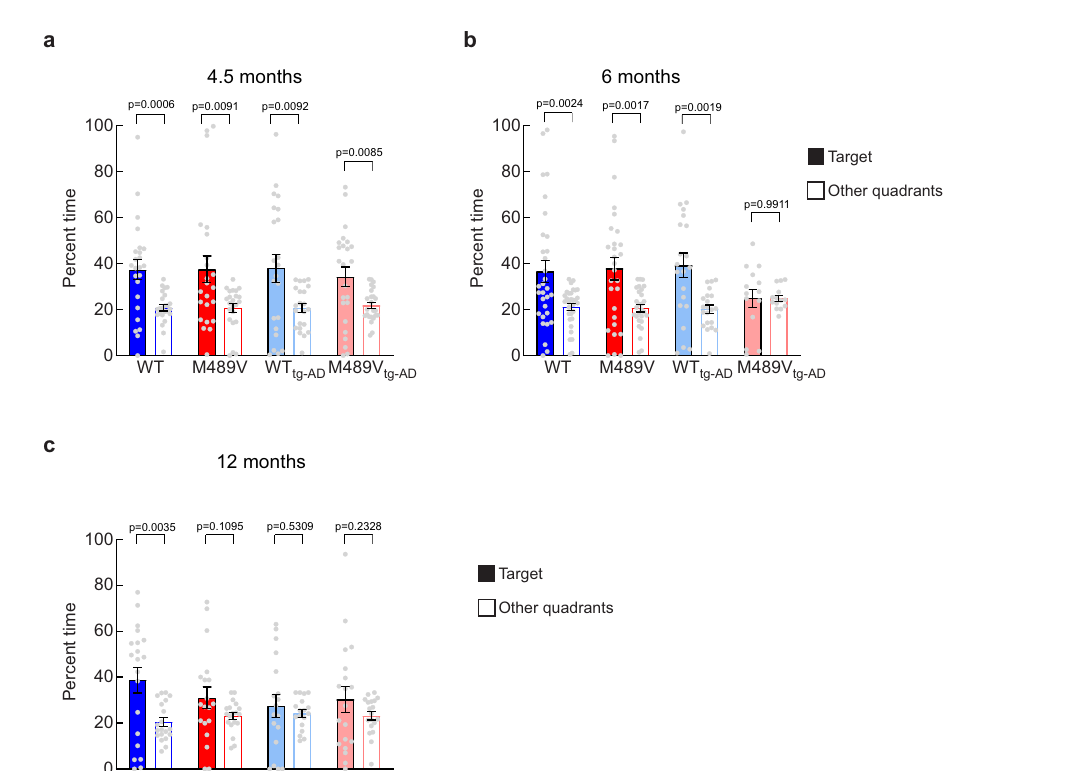
showing the distribution of phosphopeptides from C9 Graph depicts the median± interquartile range (values of p <0.05 using a two-tailed Student ’ s t test, n =3 biological independent samples). Right. GO enrichment analysis of C9 peptides using DAVID. e STRING analysis of proteins whose phosphopeptides were present in C9. Red represents proteins in the mTOR signaling pathway, green in the MAPK signaling pathway and blue represents proteins involved in neuron projection. f Left. Immunoblot of pERK1/2 (T202/Y204 for ERK1 and T185/Y187 for ERK2) and total ERK1/2 in brain lysates obtained from WT non-tg-AD (WT), M489V non tg-AD (M489V), WT tg-ADand M489V tg-AD mice at6 months.Right. ERK1 (top)or ERK2 (bottom) phosphorylation re fl ects the normalized phospho-signal relative to total ERK. Data represent the average normalized intensity±SEM (ANOVA was used for statistical analysis, followed by post hoc two-tailed Student ’ s t test). g Quanti fi cation of ERK phosphopeptides detected by phosphoproteomics in 6- month-oldsamples(mean±SD).Sourcedataanduncroppedblotsfor c and f arein the Source Data fi le.